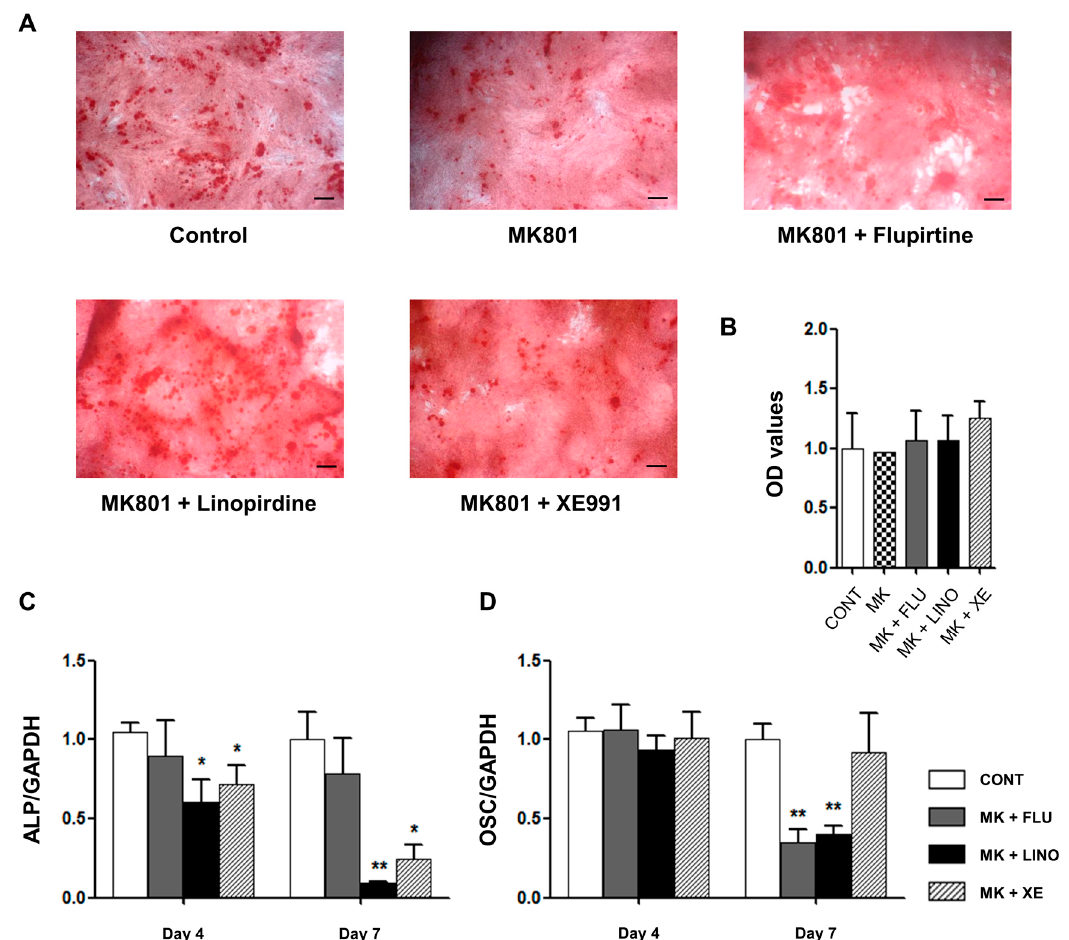
Figure 12. Suppressive effect of MK801, an NMDA (N-methyl-D-aspartate) receptor antagonist, on osteoblastic differentiation promoted by K V 7.3 blockers. ( A ) Alizarin Red S staining showed that MK801 (50 μ M) treatment co-applied with flupirtine (30 μ M), linopirdine (30 μ M), or XE991 (10 μ M) produced amounts of calcium deposits similar to those of the controls ( n = 3); ( B ) The OD values are shown parallel to Alizarin Red S staining results. The relative mRNA expression levels of osteoblastic differentiation markers, including ALP and OSC, were measured with qRT-PCR and normalized against GAPDH (glyceraldehyde 3-phosphate dehydrogenase) expression ( n = 3); ( C ) At days 4 and 7, MK801 treatment with linopirdine or XE991 attenuated ALP mRNA expression; ( D ) At day 7, MK801 treatment with flupirtine or linopirdine significantly reduced OSC mRNA expression. Data are presented as mean ± SEM. * p < 0.05 and ** p < 0.01. Scale bar represents 100 μ m. CONT: non-treated controls; MK: MK801; FLU: flupirtine; LINO: linopirdine; XE: XE991; ALP: alkaline phosphatase; OSC: osteocalcin; OD: optical density.